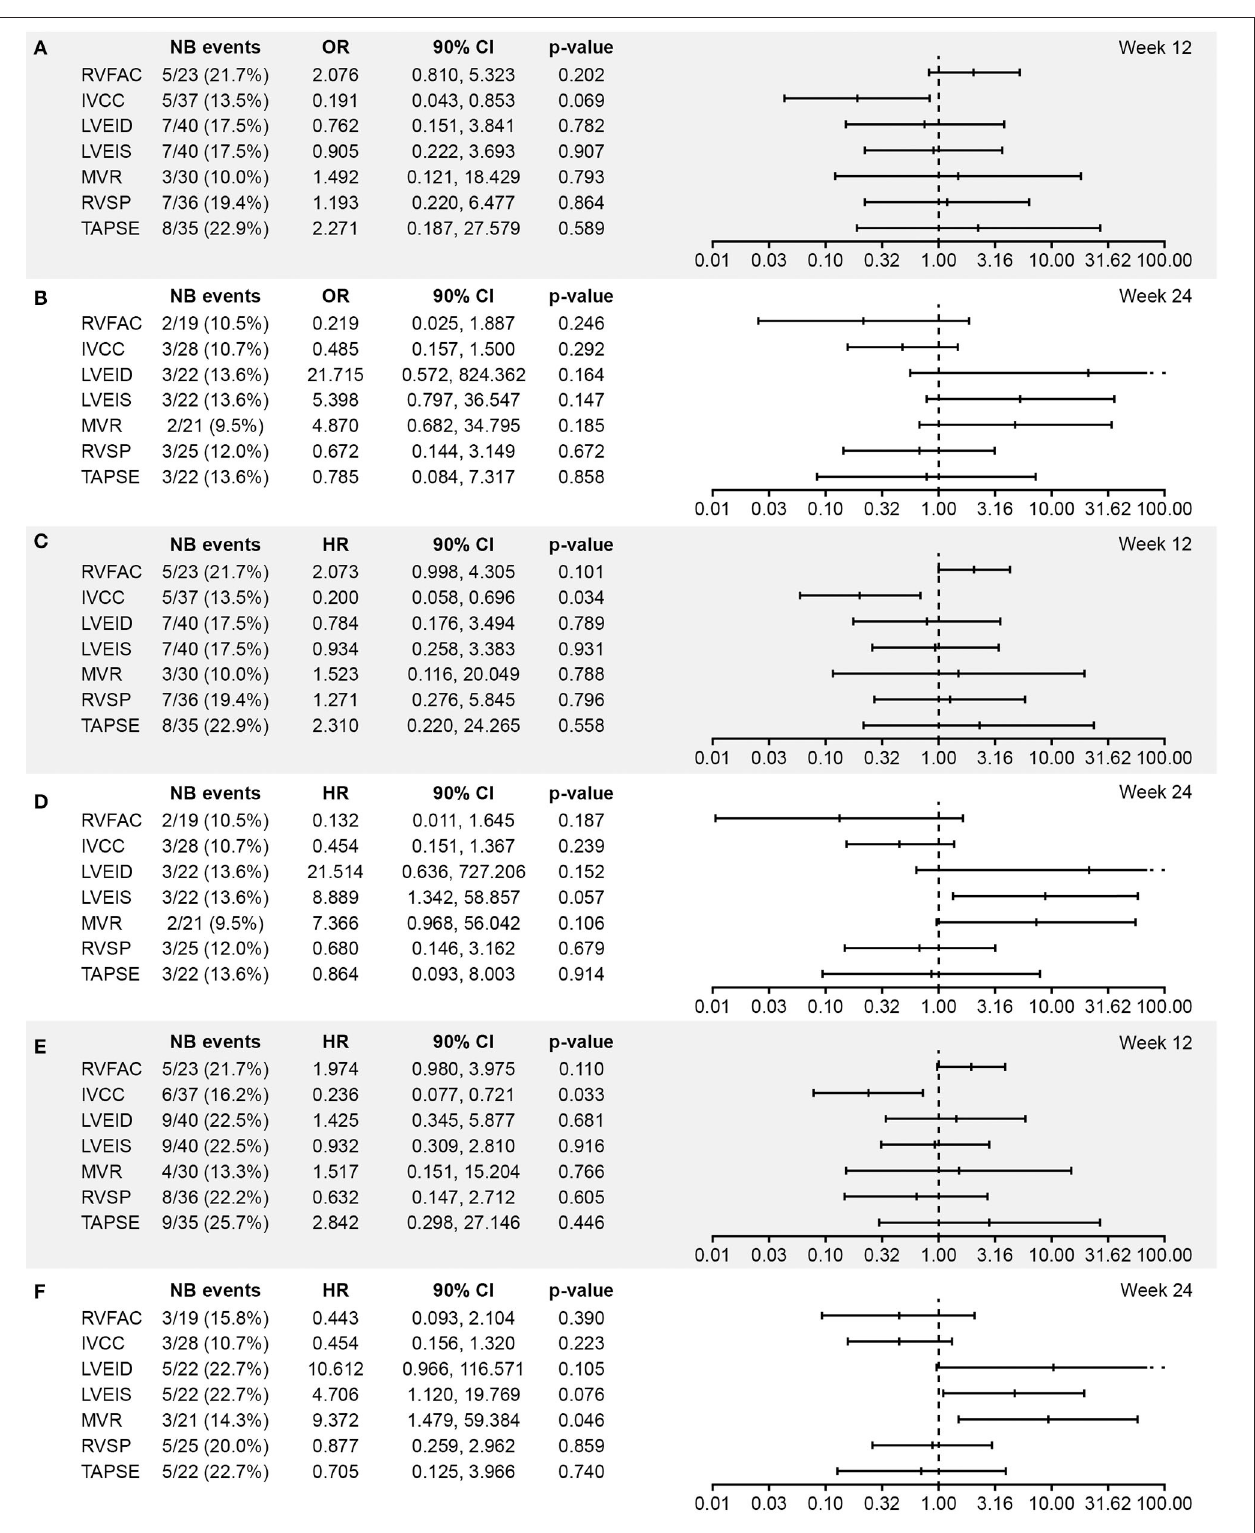
FIGURE 2 | Association between worsening from baseline in echocardiographic parameters and (A,B) vital status at EOS, (C,D) time to death, and (E,F) time to PAH worsening at Week 12 and 24, respectively (excluding patients with shunts, i.e., the echo/Doppler set; N = 56). Analysis based on logistic regression for ORs and